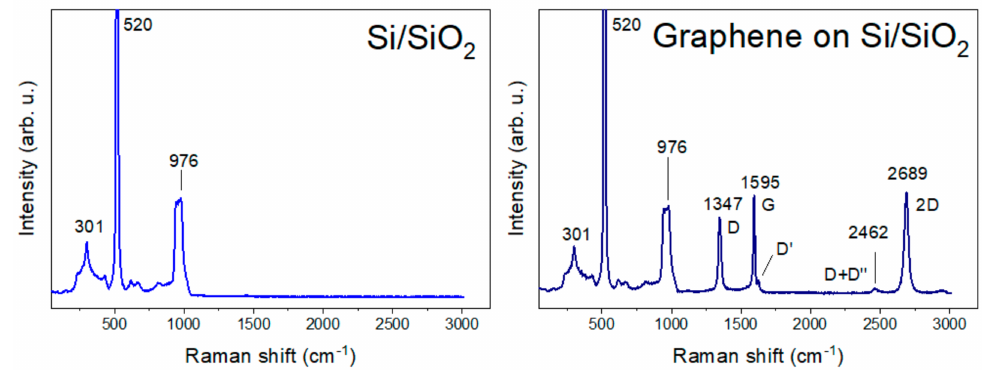
Figure 2. Raman spectra of Si / SiO 2 substrate and graphene on Si / SiO 2 substrate.